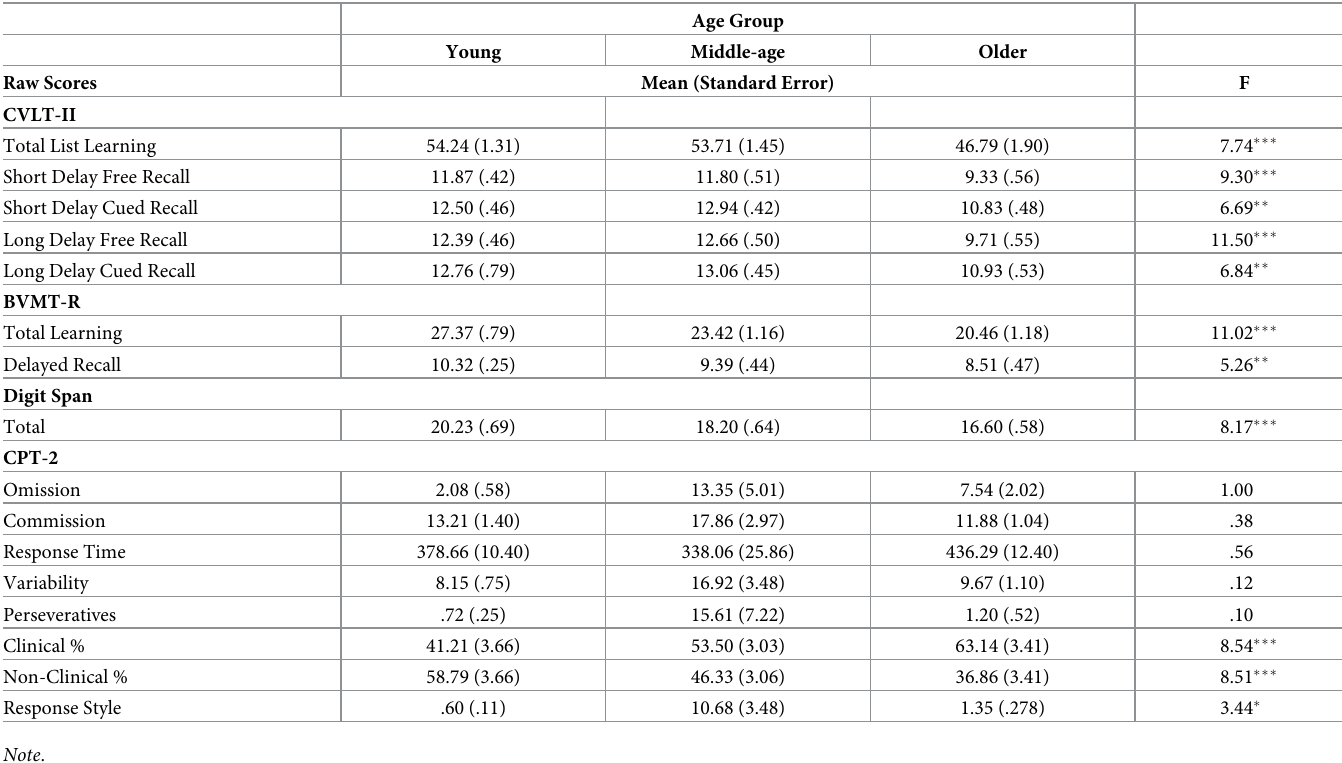
Table 4. Raw score means and standard error of cognitive performance for the main effect of age